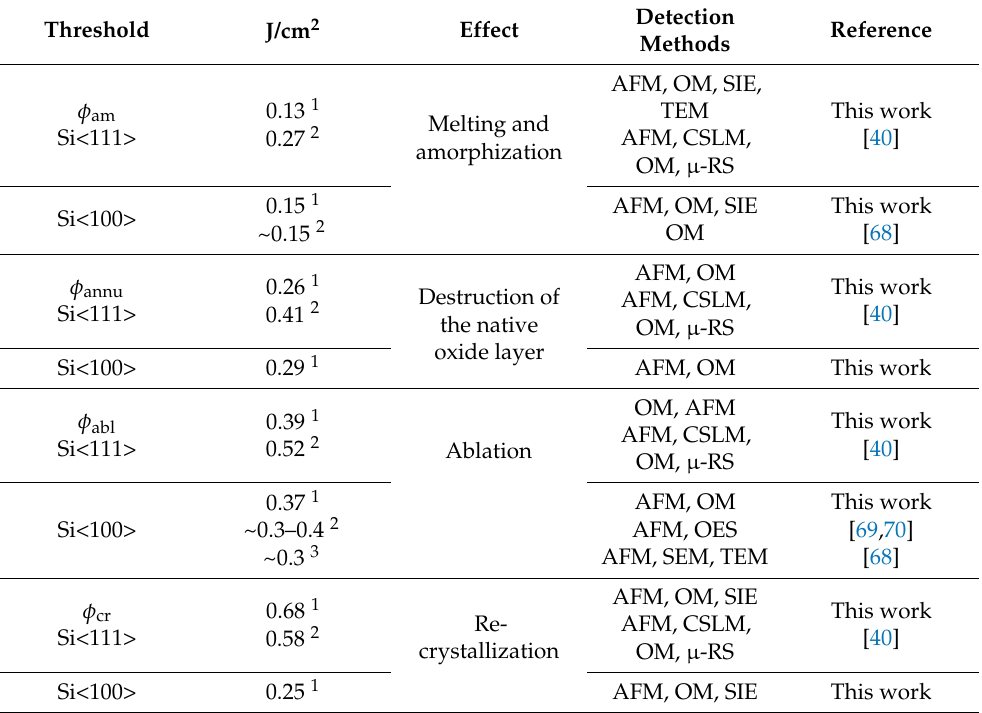
Table 1 compiles the different threshold fluences ( φ am , φ annu , φ abl , φ cr ) analyzed in this work along with a comparison to other relevant literature values. Table 1. Characteristic threshold fluence for the irradiation of single-crystalline silicon in air or vacuum by single Ti:Sapphire fs-laser pulses ( τ = 30 fs to 150 fs, λ = 780 nm to 800 nm, normal incidence); specific experimental conditions are indicated as footnotes. Abbreviations: AFM: atomic force microscopy, CSLM: confocal scanning laser microscopy, OM: optical microscopy, OES: